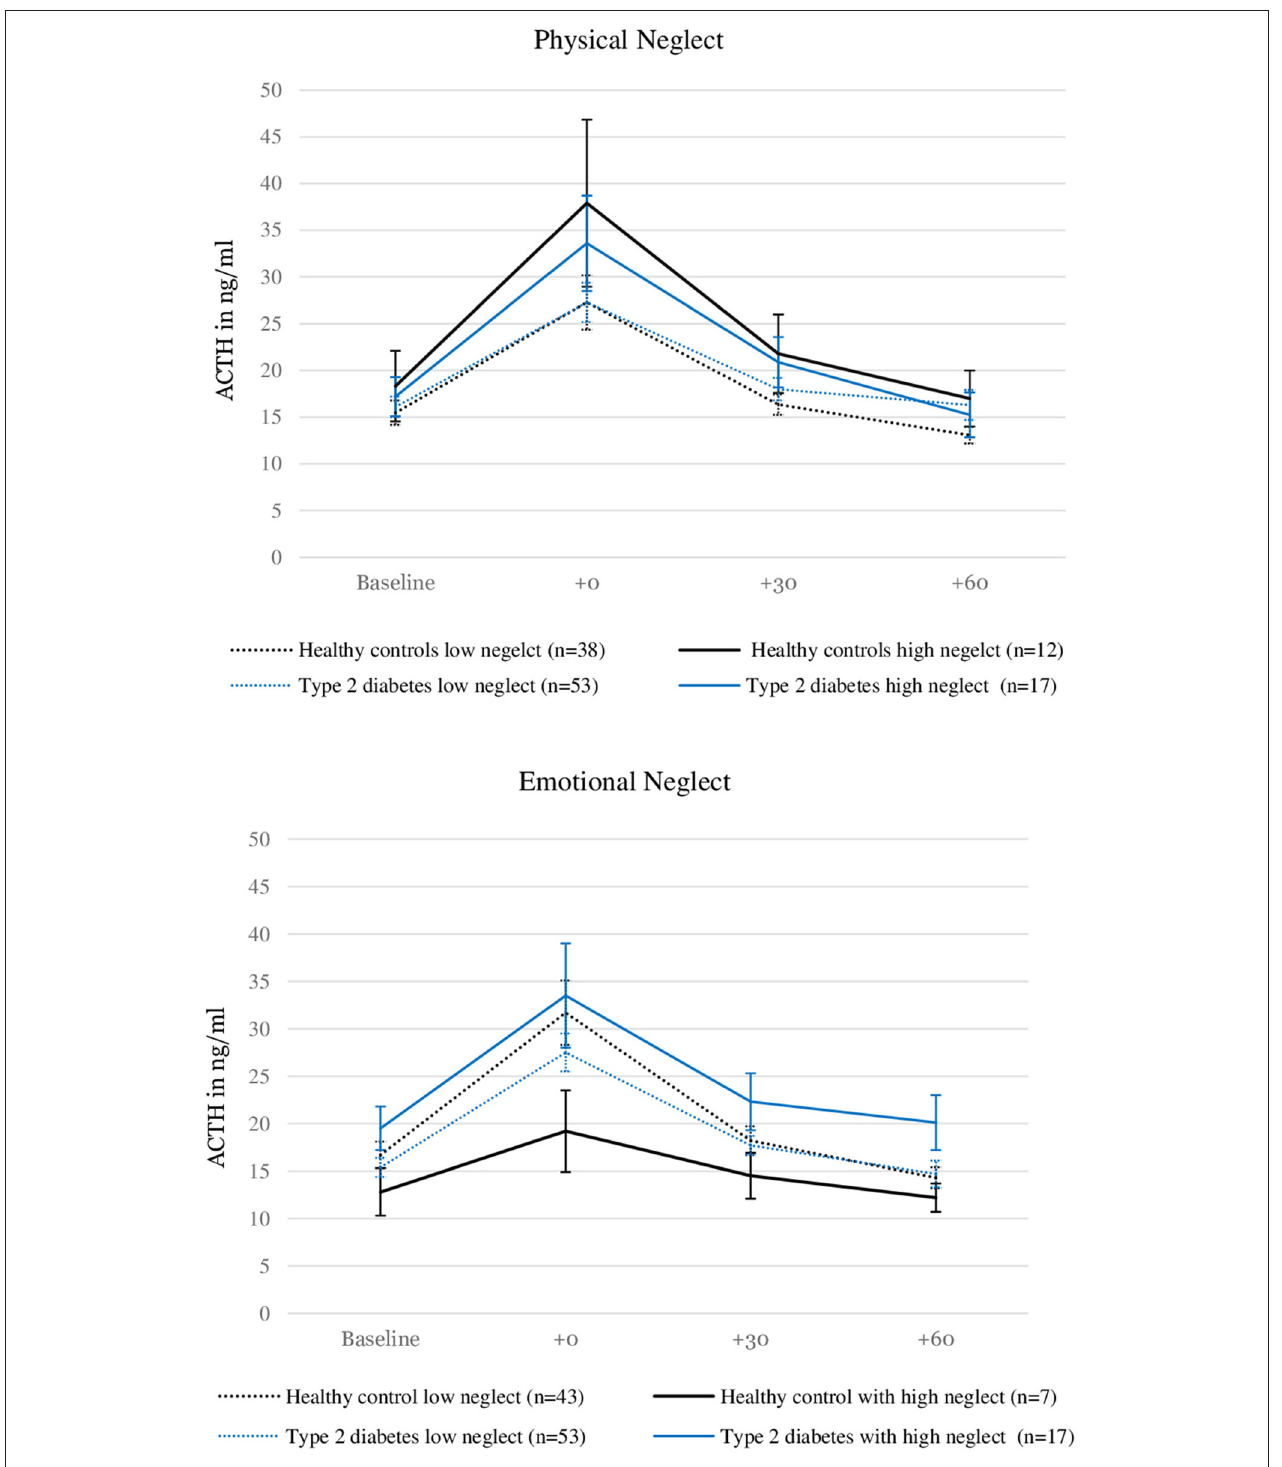
FIGURE 2 | ACTH levels before and after stress induction in patients with type 2 diabetes and healthy controls with and without the experience of “moderate to severe” childhood physical and emotional neglect. Depicted are average values and standard errors. Grouping the sample according to reports of moderate to severe neglect was done solely for the purpose of the visualization. Group differences were not tested in this study. Details on the descriptive values displayed in the figure can be found in the Supplementary Material .